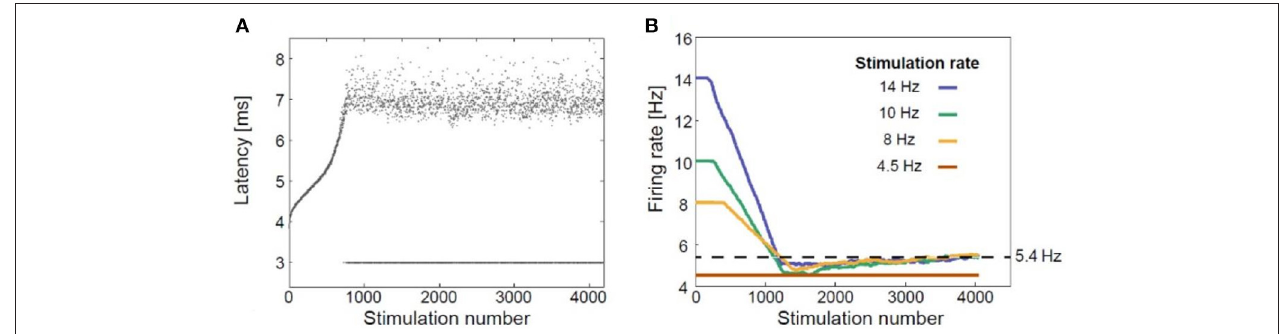
FIGURE 1 | Neuronal plasticity. (A) The neuronal response latency (NRL) of a cultured cortical neuron functionally separated from its network using a pharmacologic block, stimulated at a frequency of 10Hz. Response failures are represented by dots at NRL = 3ms. (B) Firing rates for different stimulation rates using a sliding window of 1,000 stimulations, indicating a saturated firing rate ( ∼ 5.4Hz, dashed line) independent of the applied stimulation rate. Adapted from Goldental et al. (2016) with the author’s